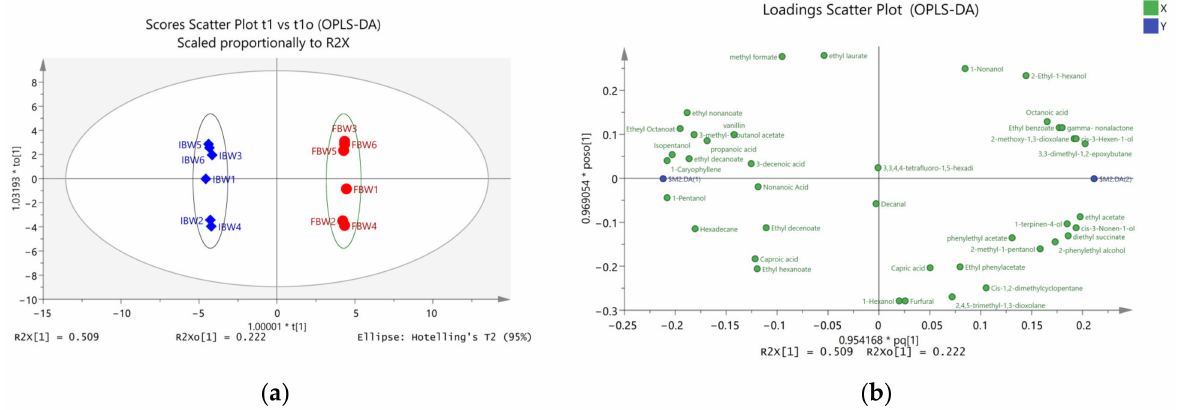
Figure 2. The OPLS-DA score plot and loading plot of volatile compounds: ( a ) Scores scatter plot t1 vs. t1o; ( b ) loadings scatter plot pq1 vs.